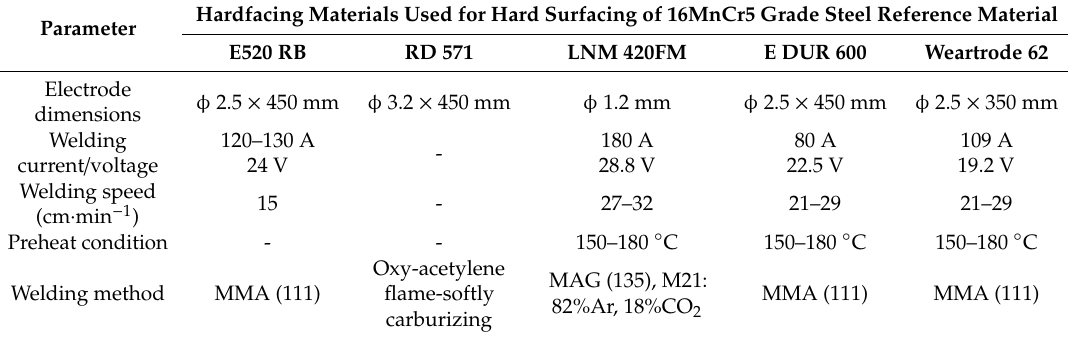
Table 3. Welding methods and process parameters used for fabrication of the